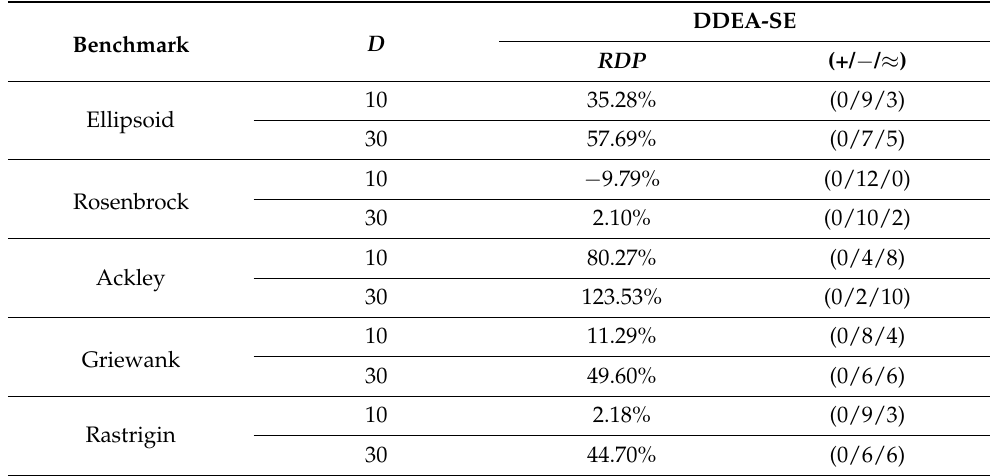
Table 3. Average RDP of DDEA-SE on different benchmark problems in noisy environment and the number of noise levels whose optimization results are better/similar/worse than the results obtained in ideal environment.